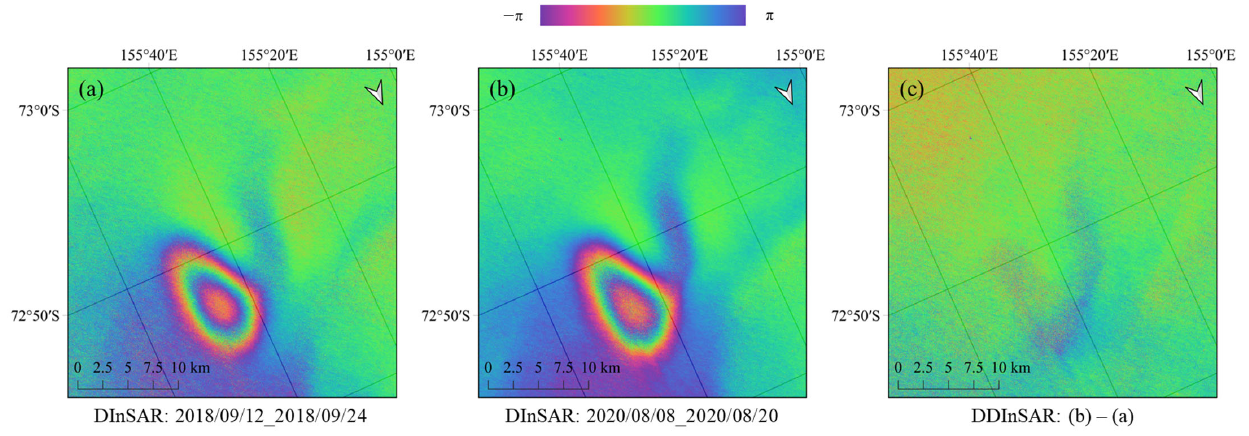
Figure 5. Example images of DDInSAR processing in the study area: ( a ) the DInSAR image from 24 September 2018; ( b ) the DInSAR image from 20 August 2020; and ( c ) the DDInSAR image from ( a , b ).